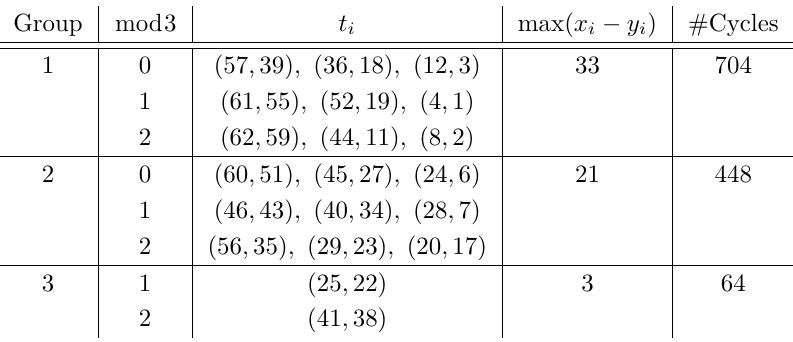
Table 3: Concurrent execution of the t i ’s in the PRESENT permutation Group